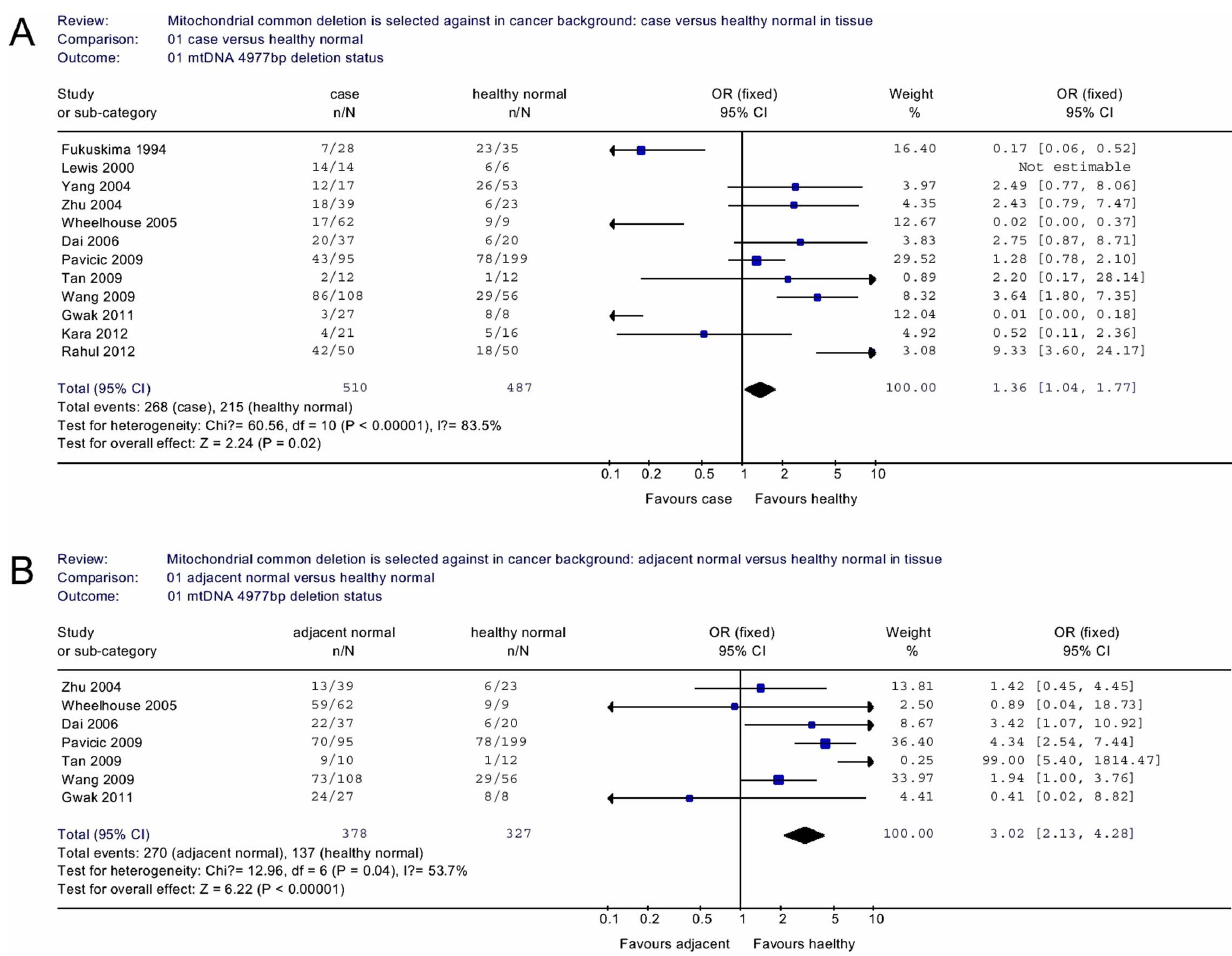
Figure 3. Odds ratios (ORs) and 95% confidence intervals (CIs) for various cancer types associated with mtDNA 4977 bp deletion. (A) case/healthy normal group. (B) adjacent normal/healthy normal group of tissue sample stratified analysis.